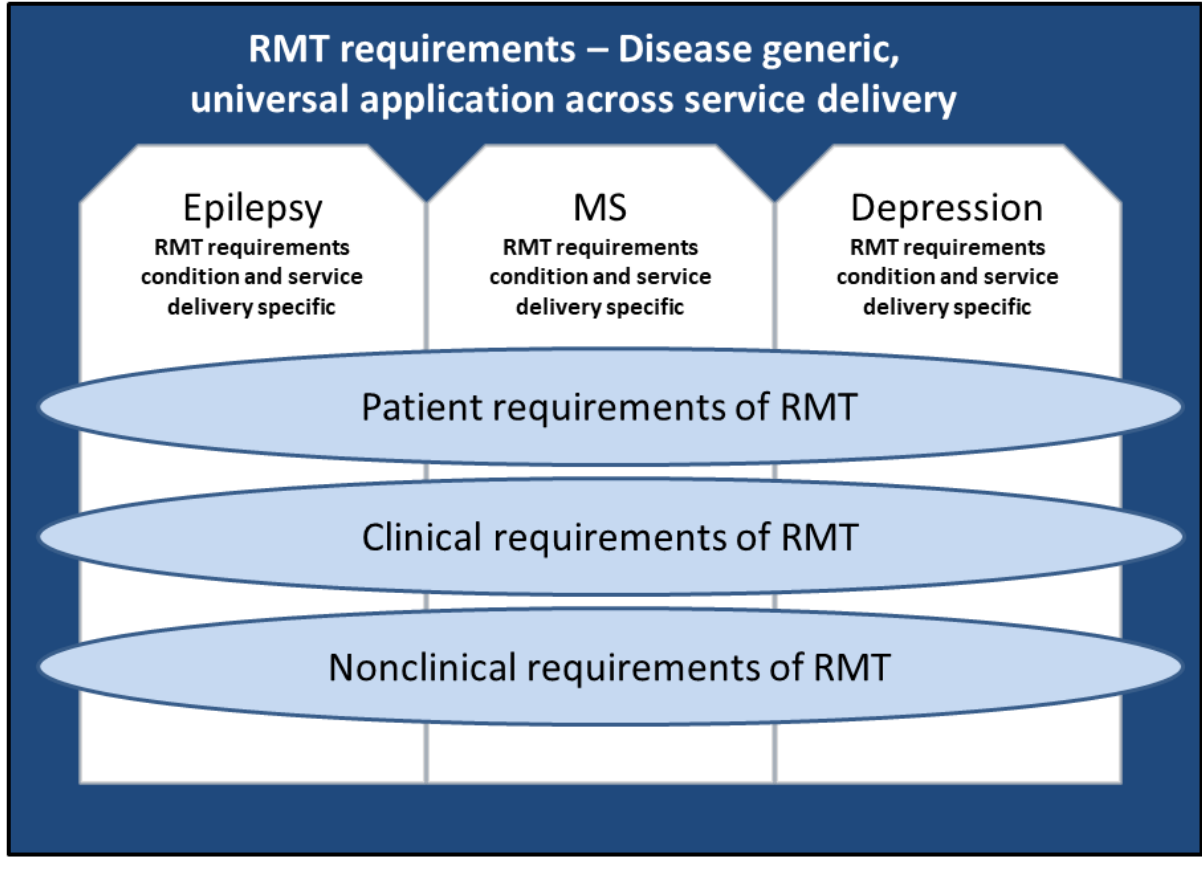
Figure 2. Diagram showing the coverage of the universal points of care methodology in the development of a novel remote measurement technology system. MS: multiple sclerosis; RMT: remote measurement